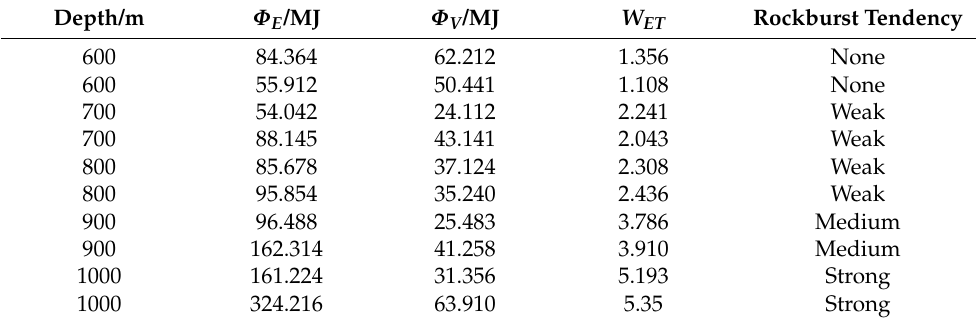
Table 2. Rockburst tendency based on elastic energy index [25,26].